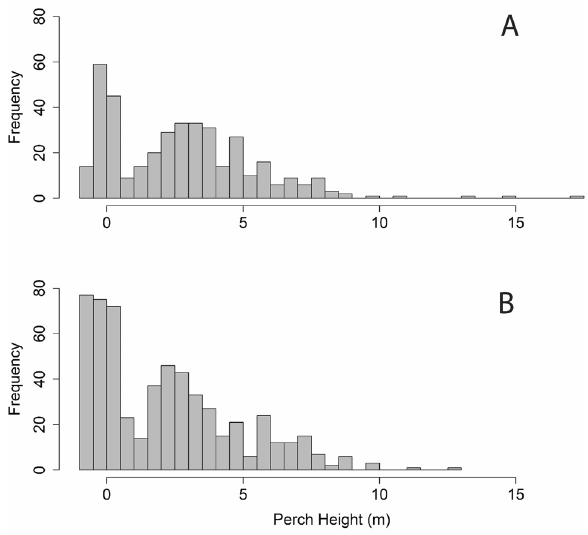
Figure 5. Frequency distribution of perch heights (m) for radiotelemetered male ( A , n = 9) and female ( B , n = 11) brown treesnakes ( Boiga irregularis ) after snake suppression within the Habitat Management Unit (HMU) on Guam. Notice the difference in the frequency of heights < 0 (underground) between the sexes reflecting an increased use of underground retreats by